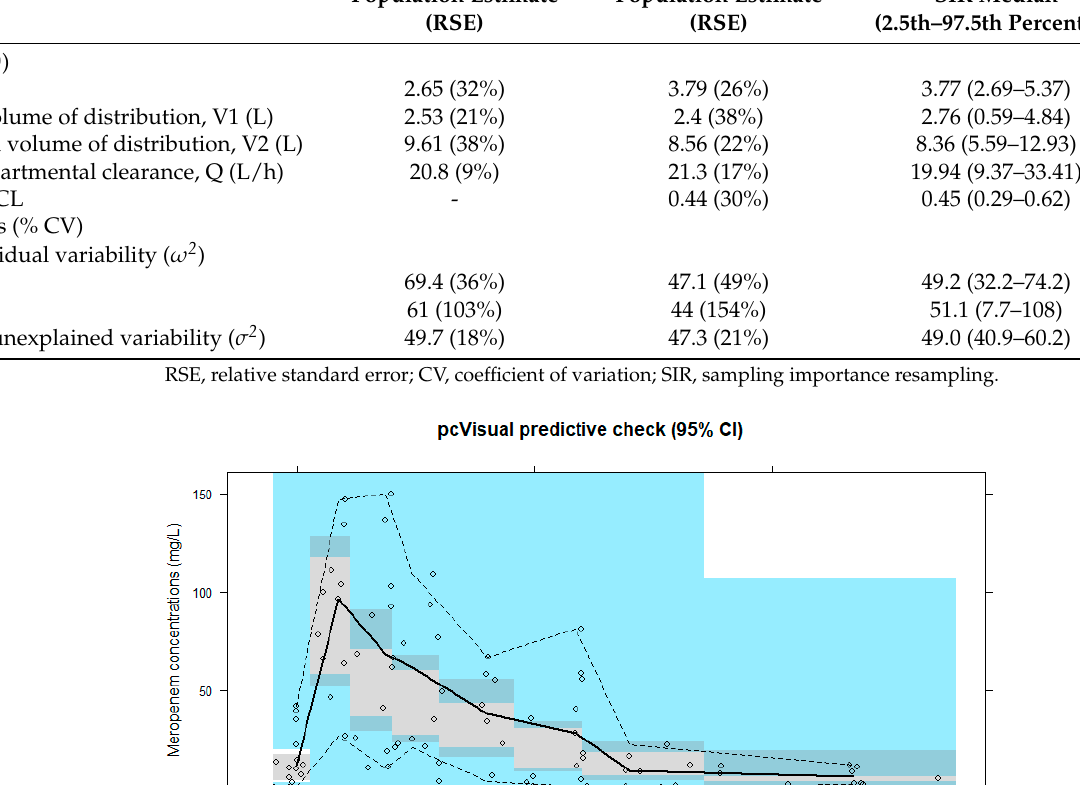
Table 2. Parameter estimates of the base model and final model.